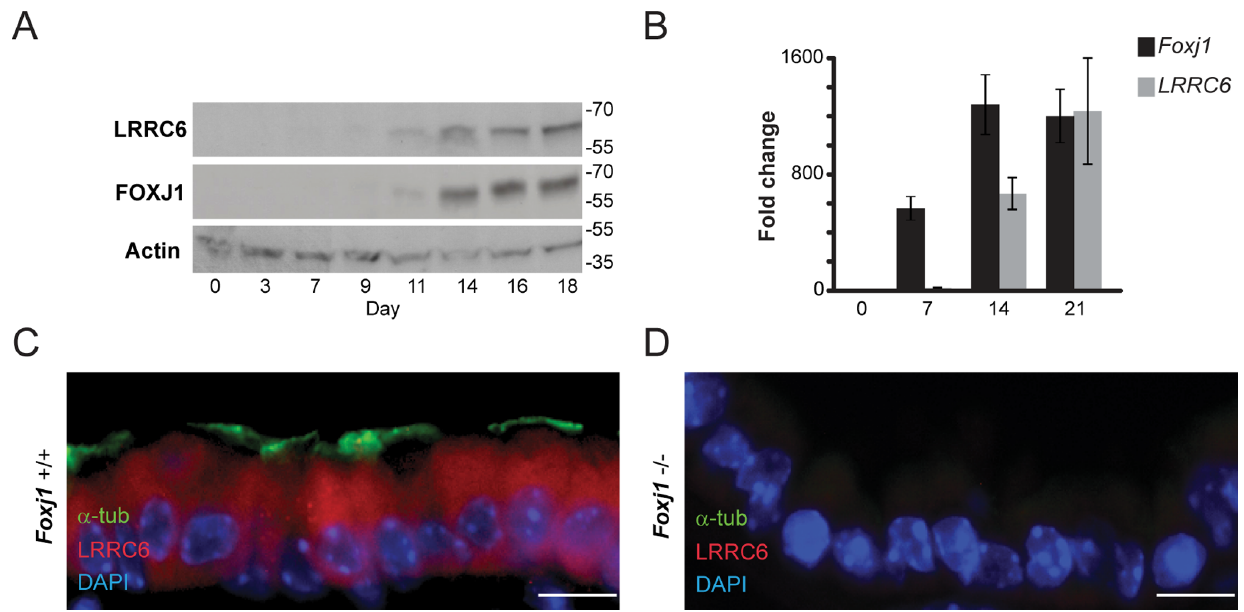
Figure 6. LRRC6 relation to Foxj1 . Immunoblot analysis of differentiating human tracheal epithelial cells collected from healthy subjects and grown at an air-liquid interface ( A ) showing LRRC6 paralleling Foxj1 expression. LRRC6 expression measured using RT-PCR ( B ), increased significantly after the onset of ciliogenesis (ANOVA, p=0.0004; individual student two-tail t-test, p=0.003 and p=0.001, comparing expression between day 0 and day 7, and between day 7 and day 14, respectively). LRRC6 expression in tracheal airway epithelial cells isolated from wild-type mice ( Foxj1 + / + ) ( C ), compared to cells from Foxj1-deficient littermates ( Foxj1 2 / 2 ) ( D ), showing that virtually no LRRC6 was detected in the cytoplasm of Foxj1 2 / 2 cells. Immunofluorescent staining for LRRC6 (red) and a -tubulin (green). (scale bar=10 m